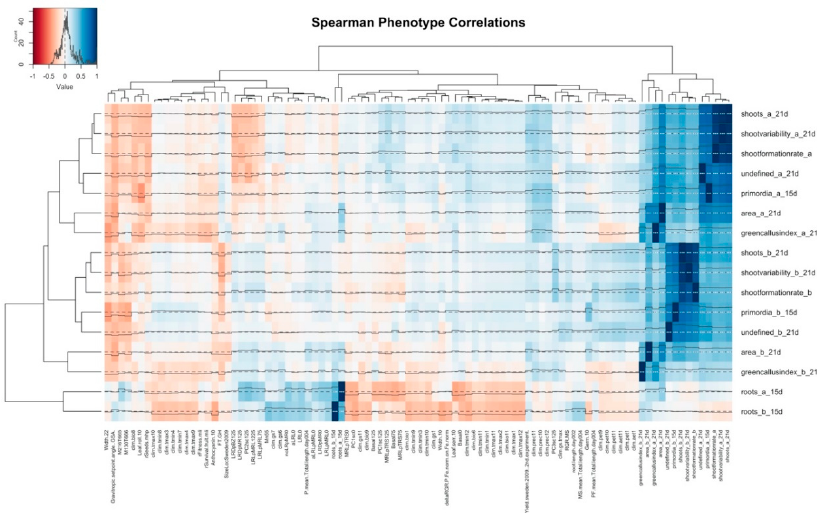
Figure 2. Spearman’s rho for pairwise comparisons between 16 regeneration traits in 170 Arabidopsis accessions [80] and 78 public phenotypes from AraPheno scored in at least 50 of these accessions and was significantly associated to at least one regeneration trait (FDR < 0.3) [153]. Dendrograms are based on Euclidean distances, and the legend in the upper left corner shows the color gradient and histogram of correlation coefficients. The value of the latter is also reflected by grey trace lines in the main plot. Significance is based on FDR-adjusted p -values from Spearman’s test (. = p ≤ 0.1, * = p ≤ 0.05, ** = p ≤ 0.01, *** = p ≤ 0.001). Accurate descriptions of all phenotypes can be found at https: // arapheno.1001genomes.org /